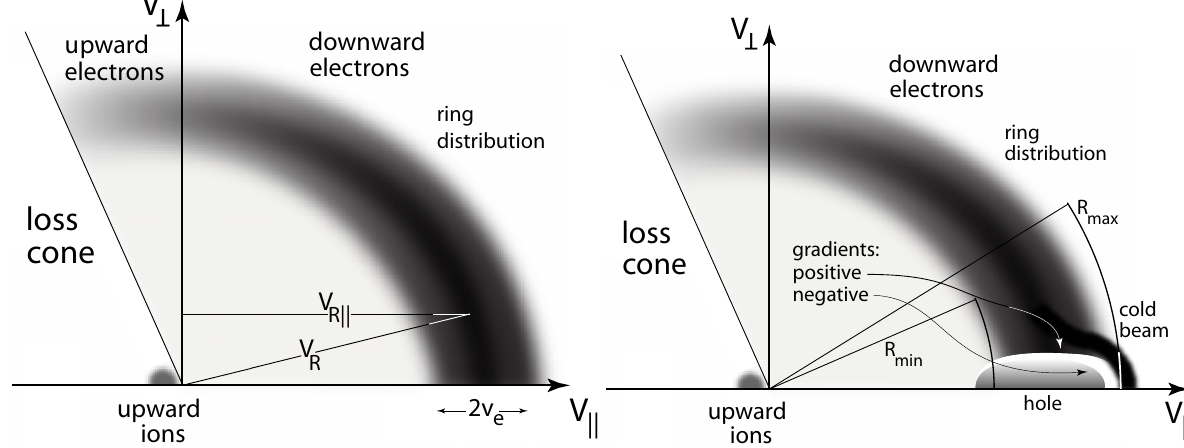
Fig. 8. A schematic of a broad electron hole evolving in velocity space under the condition of a loss-cone-truncated ring-(“horseshoe”)- distribution (shown on the left) with parallel velocity spread 2 v e substantially less than the (parallel) ring speed V R k . Under this condition the two-stream instability evolves and generates electron holes on the low parallel-velocity side of the warm-beam distribution (as shown on the right). The hole grows and is attracted into the beam into parallel direction. It traps electrons and accelerates part of the beam to high parallel speeds into a fast cool beam. Its finite extension in perpendicular velocity implies the production of perpendicular velocity-space gradients as shown by arrows. A steep positive gradient exists at higher perpendicular velocities pointing from the interior of the hole into the beam distribution, while a flat negative gradient points from the boundary of the hole into the warm trapped electron component which fills the